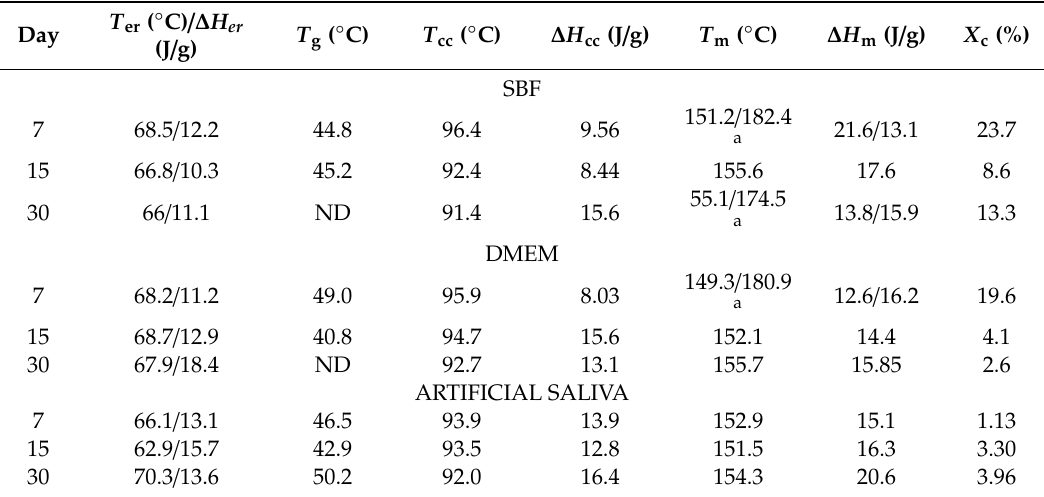
Table 3. Transition temperatures and enthalpies for non-irradiated PLGA nonwovens obtained in di ff erent in vitro degradation time.